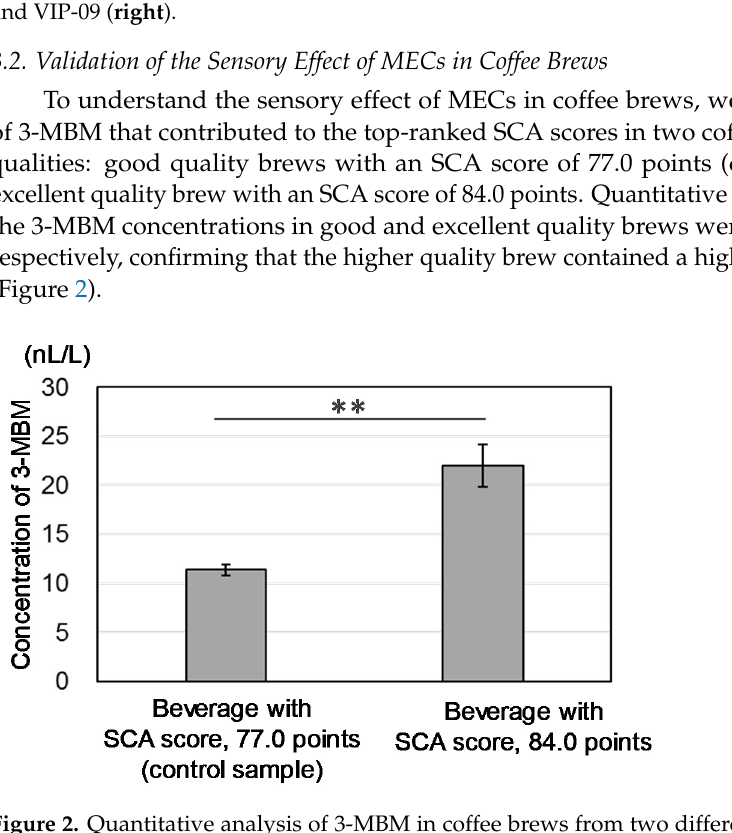
Figure 3. Sensory evaluation of coffee brews without and with added 3-MBM (5 nL/L or 10 nL/L). ( A ) Fresh-fruity aroma and ( B ) cleanness were evaluated by four trained panelists. Statistical significance is indicated by the Student t test (** p < 0.01). Recently, Niu et al. reported an enhancing or synergistic effect of perceptual interac- tion between ethyl-ester aroma compounds in Langjiu [46]. Xiao et al. studied the evalu- ation of the interaction between esters and sulfur compounds in pineapple, suggesting enhancement, masking, and synergistic effects [47]. Miyazawa reported that specific com- pounds (carboxylic acids (C1, C2, and C4) under odor threshold values) affect other aroma compounds and increase coffee aroma intensities [48–51]. However, the reduction of off- flavor in coffee brews has not yet been reported. To the best of our knowledge, this is the first study to report that 3-MBM is a compound contributing to the reduction of off-flavor in coffee brews and influencing flavor impression in arabica specialty coffee. 4. Conclusions This paper reported the study on the chemical compounds in specialty Arabica coffee beans. The relationship between the chemical compounds and SCA cupping scores by analyzing 16 types of Coffea arabica beans from Guatemala was investigated. Our results indicated that specialty beans with a high cupping score contain considerable amounts of